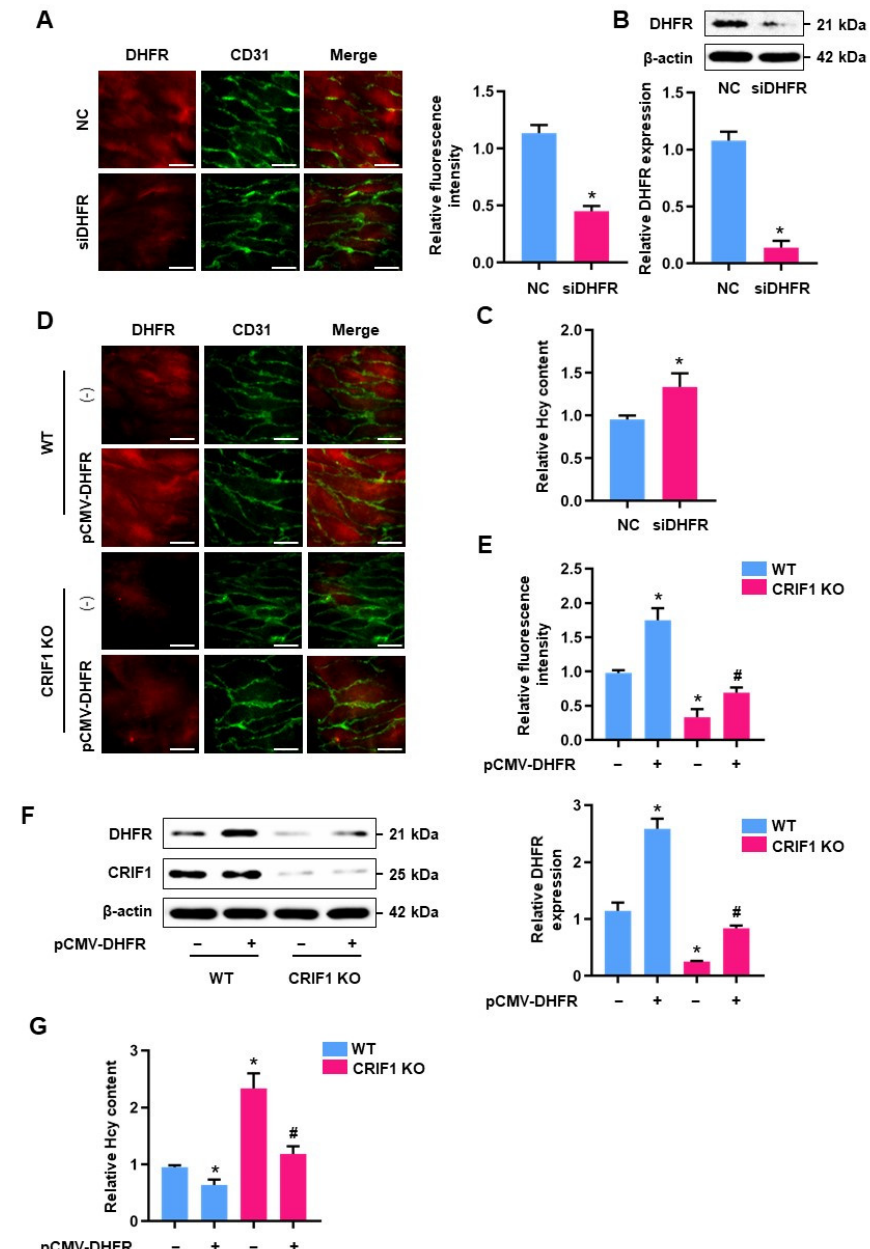
Figure 6. The effect of DHFR overexpression on homocysteine and folate intermediates in mouse endothelial cells: ( A ) Immunofluorescence staining of DHFR (red) and CD31 (green) in the NC or siDHFR-transfected aortic endothelial surface. The scale bar indicates 10 µ m. Quantification of fluorescence signal was normalized to the NC group (right). ( B ) DHFR expression of ex vivo transfection in mouse aortic endothelium. Immunoblotting analysis for quantifying the DHFR level is shown as a graph. ( C ) Relative quantification of the Hcy content in aortic endothelial cells after ex vivo transfection of siDHFR. ( D , E ) DHFR protein levels of WT and CRIF1 KO mouse in aortic endothelium were analyzed by immunofluorescent staining after ex vivo transfection of pCMV-DHFR, and the scale bar indicates 10 µ m. Signal intensity was quantified and suggested as a graph. ( F ) Immunoblotting assay of ex vivo-induced DHFR transfection on aorta. Quantitative analysis of DHFR level is suggested as a graph, relatively. ( G ) The relative Hcy content of pCMV-DHFR treatments on aortic endothelium. Data are presented with three independent experiments as the mean ± SEM. * p < 0.05 compared with WT mice; # p < 0.05 compared with CRIF1 KO mice.